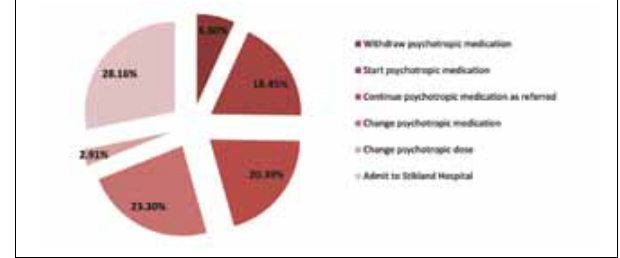
Fig. 3. Immediate post-assessment